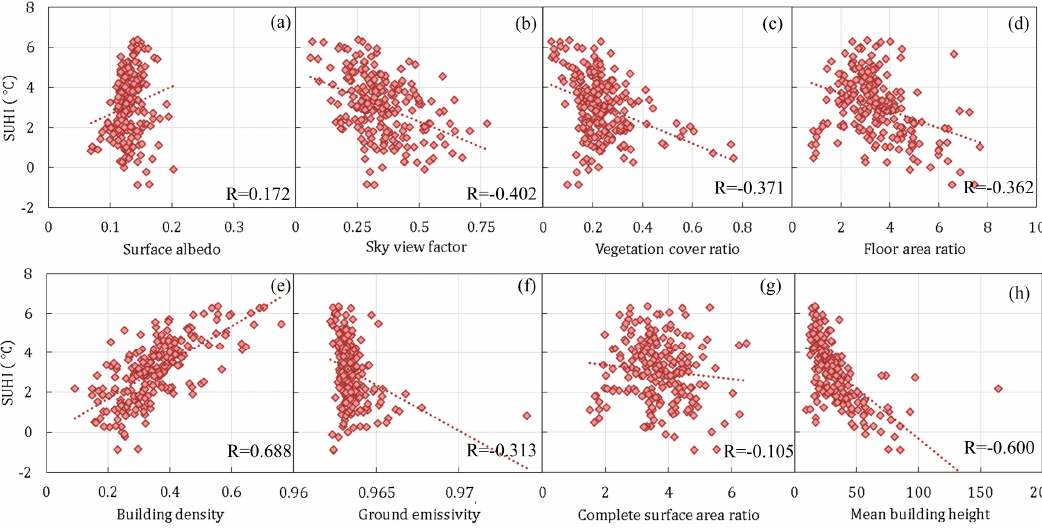
Figure 8. SUHI versus urban design factors of ( a ) surface albedo, ( b ) sky view factor, ( c ) vegetation cover ratio, ( d ) floor area ratio, ( e ) building density, ( f ) ground emissivity, and ( g ) complete surface area ratio, and ( h ) mean building height for LCZs 1–5 in the central urbanized area of